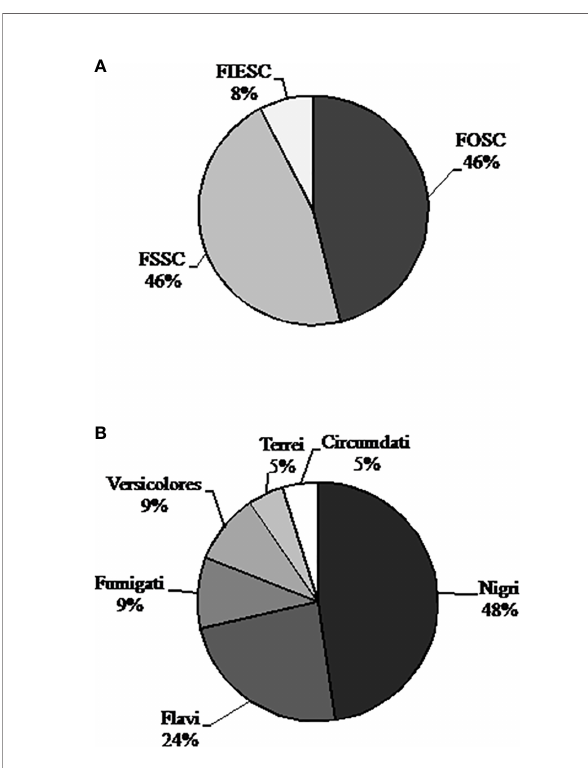
FIGURE 1 | Distribution of the Fusarium (A) and Aspergillus (B) strains among complexes or sections. Legend: FOSC - Fusarium oxysporum species complex, FSSC - Fusarium solani species complex, FIESC - Fusarium incarnatum-equiseti species